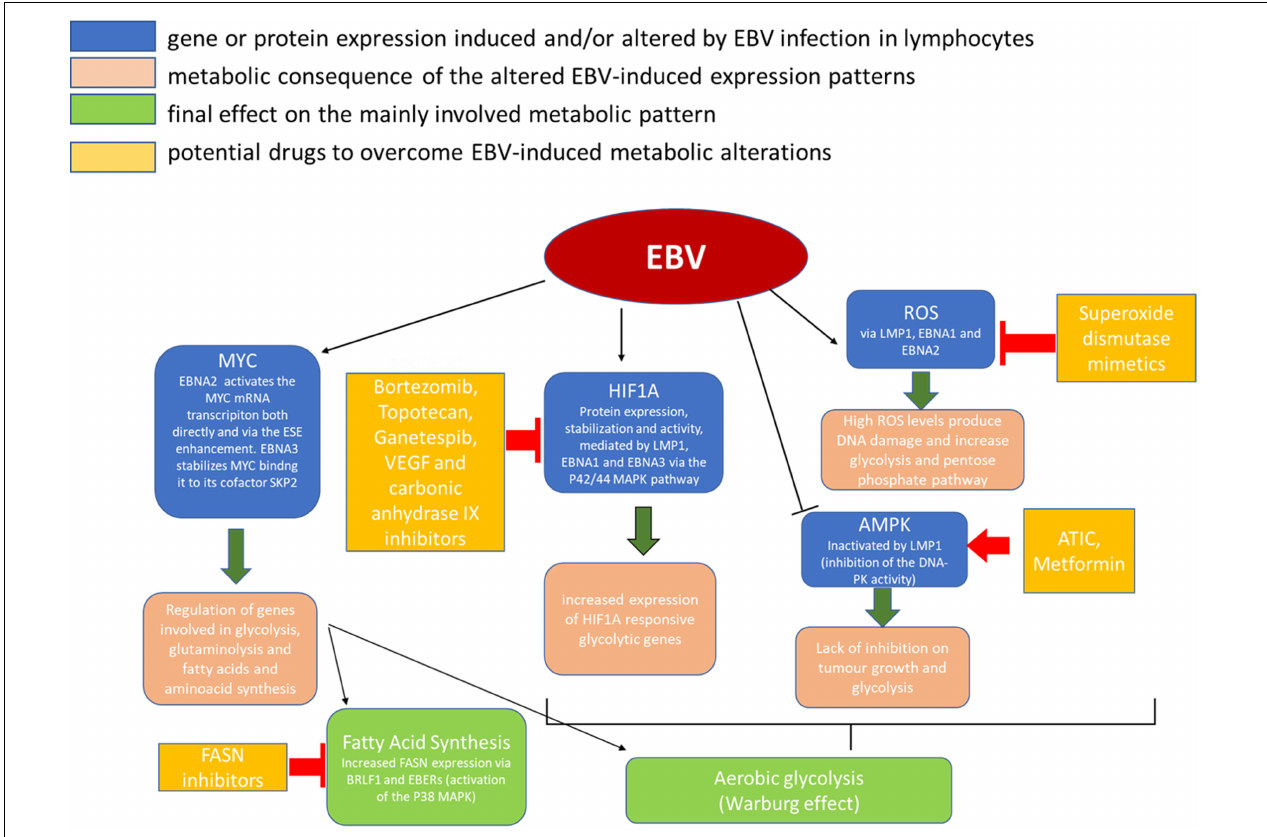
FIGURE 2 | Metabolic alterations induced in cancer cells by EBV infection and possible therapeutic